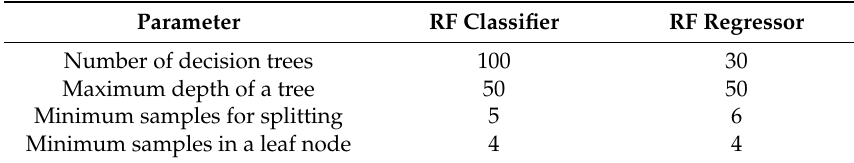
Table 3. Key parameters of RF